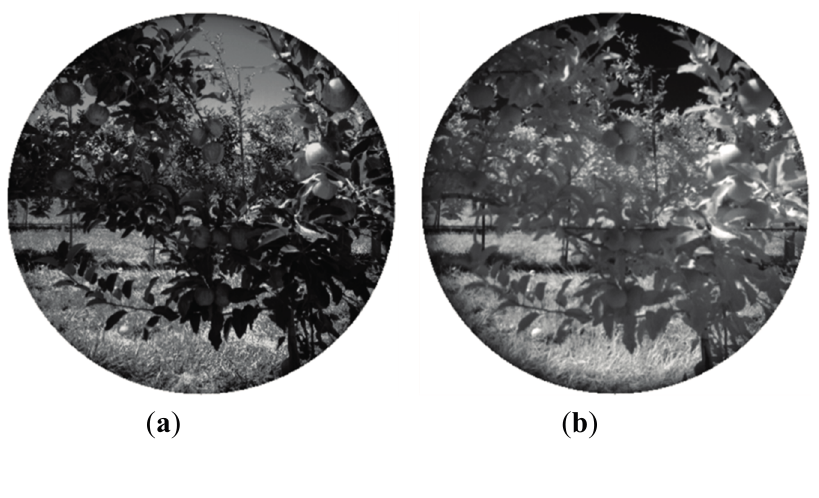
Figure 4. Apple orchard – Filtered images. ( a ) 635 nm image; ( b ) 880 nm